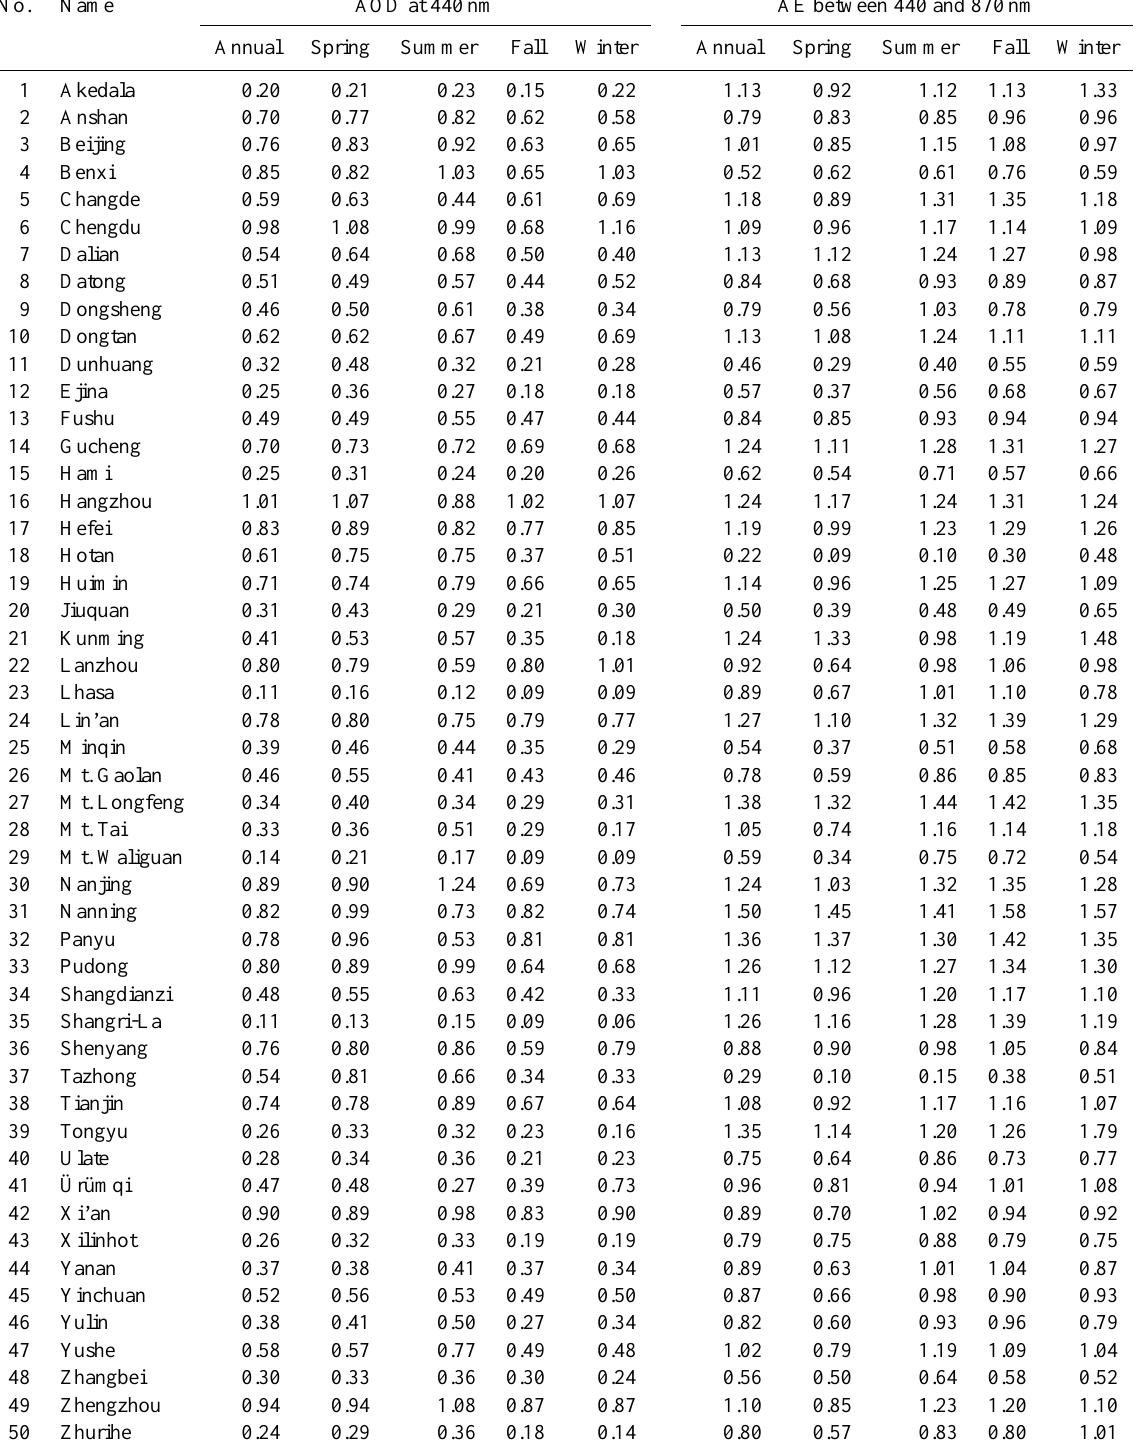
Table A2. Data for Figs.